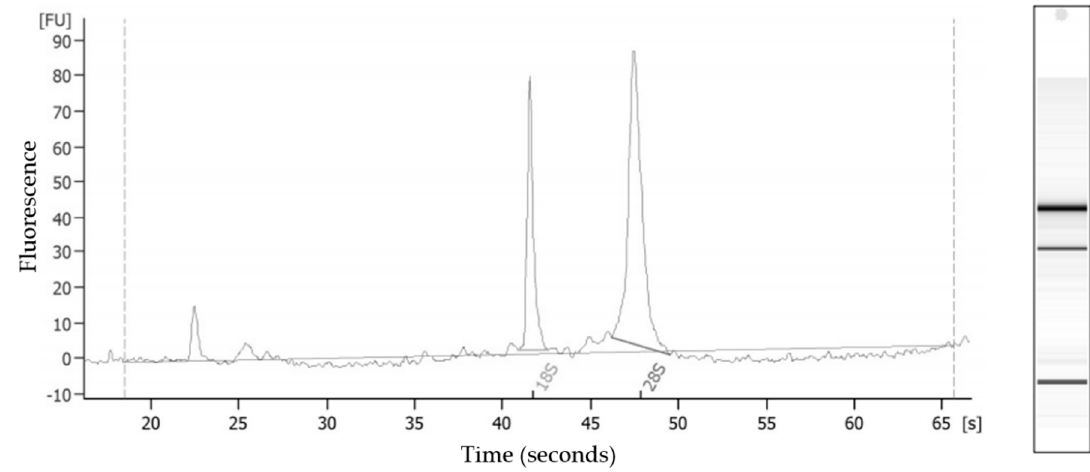
Figure 1. Gel-like image and electropherogram of intact total RNA (RNA integrity number = 9.8) from Asterias rubens pyloric ceca analyzed by the Agilent 2100 Bioanalyzer RNA 6000 Nanochip.